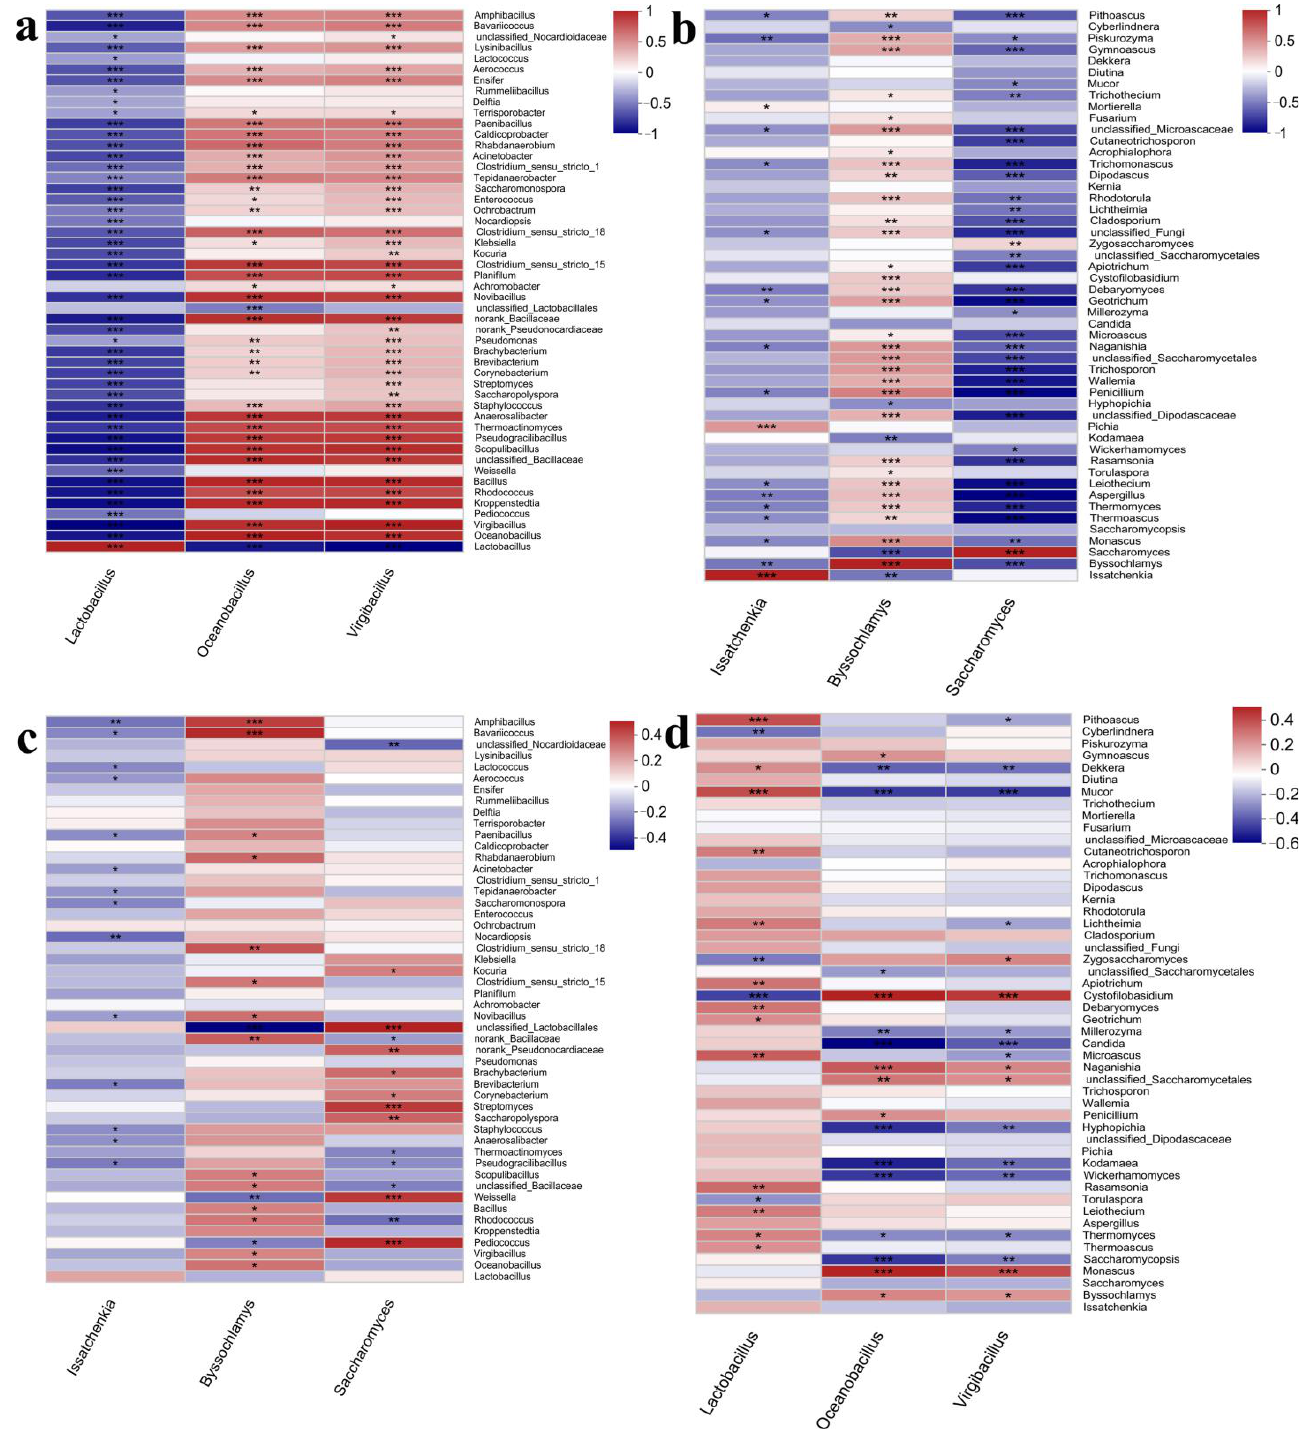
Figure 7. Reciprocal interaction analysis of the microorganisms in the fermented grains during the manufacturing process of sauce-flavor Baijiu. ( a ) the three dominant bacteria genera with other bacteria. ( b ) the three dominant fungi genera with other fungi. ( c ) the three dominant fungi genera with bacteria. ( d ) the three dominant bacteria genera with fungi. * 0.01 < p ≤ 0.05, ** 0.001 < p ≤ 0.01, *** p ≤ 0.001.